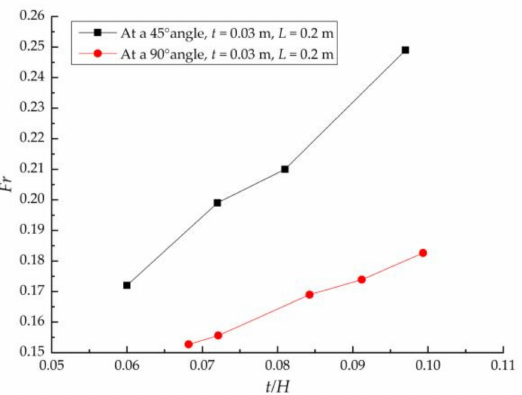
Figure 9. Relationship between critical Fr , t / H and di ff erent contact angles of ice with the pier